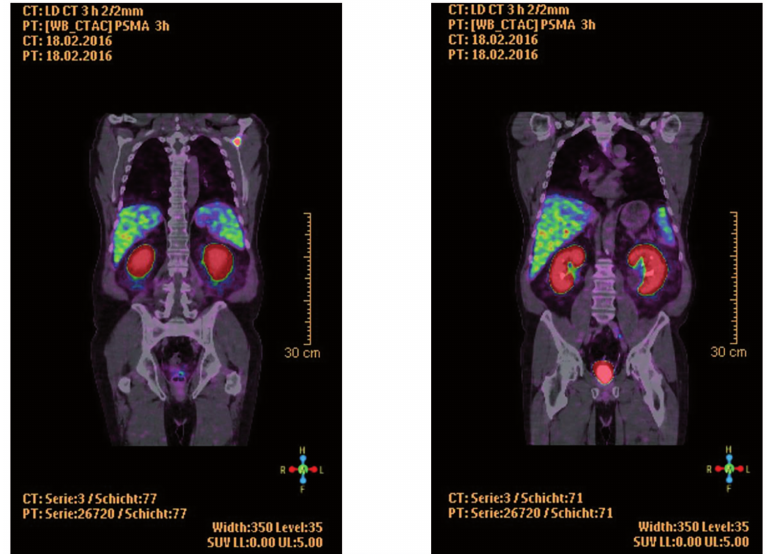
Figure 1 - Patient 1, first scan, left: osseous metastasis in the scapula, right: lymph node in the left iliac